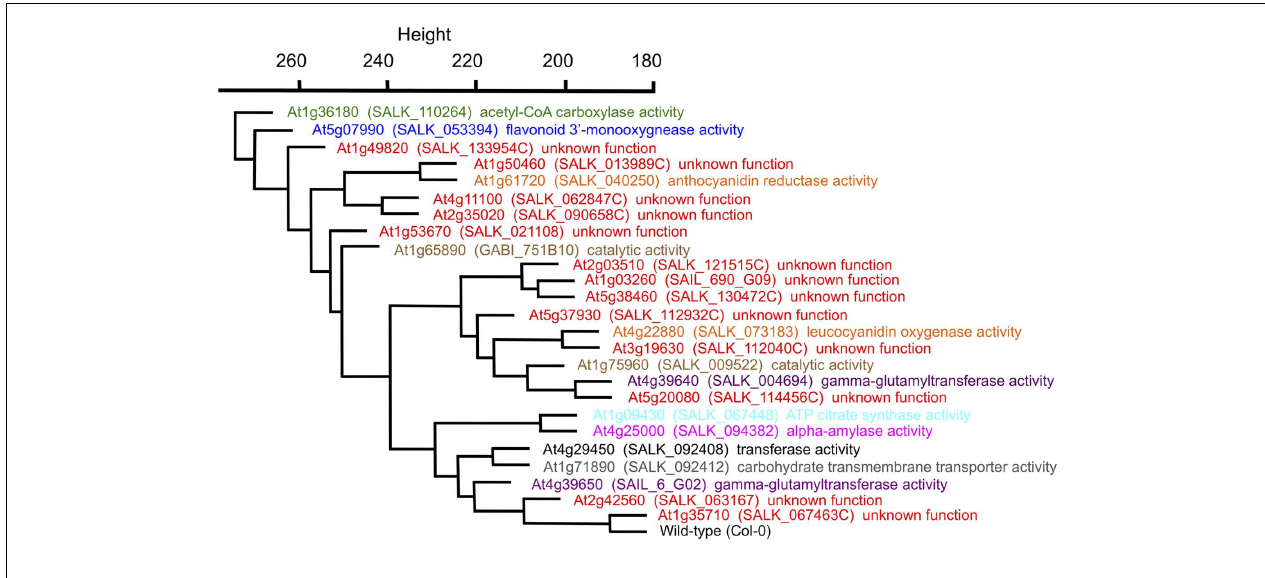
Methods,” and this distance measurement was used to generate the cluster diagram.The specific mutant allele used to characterize each gene locus, and the GO Molecular Function term that annotates each locus is identified.